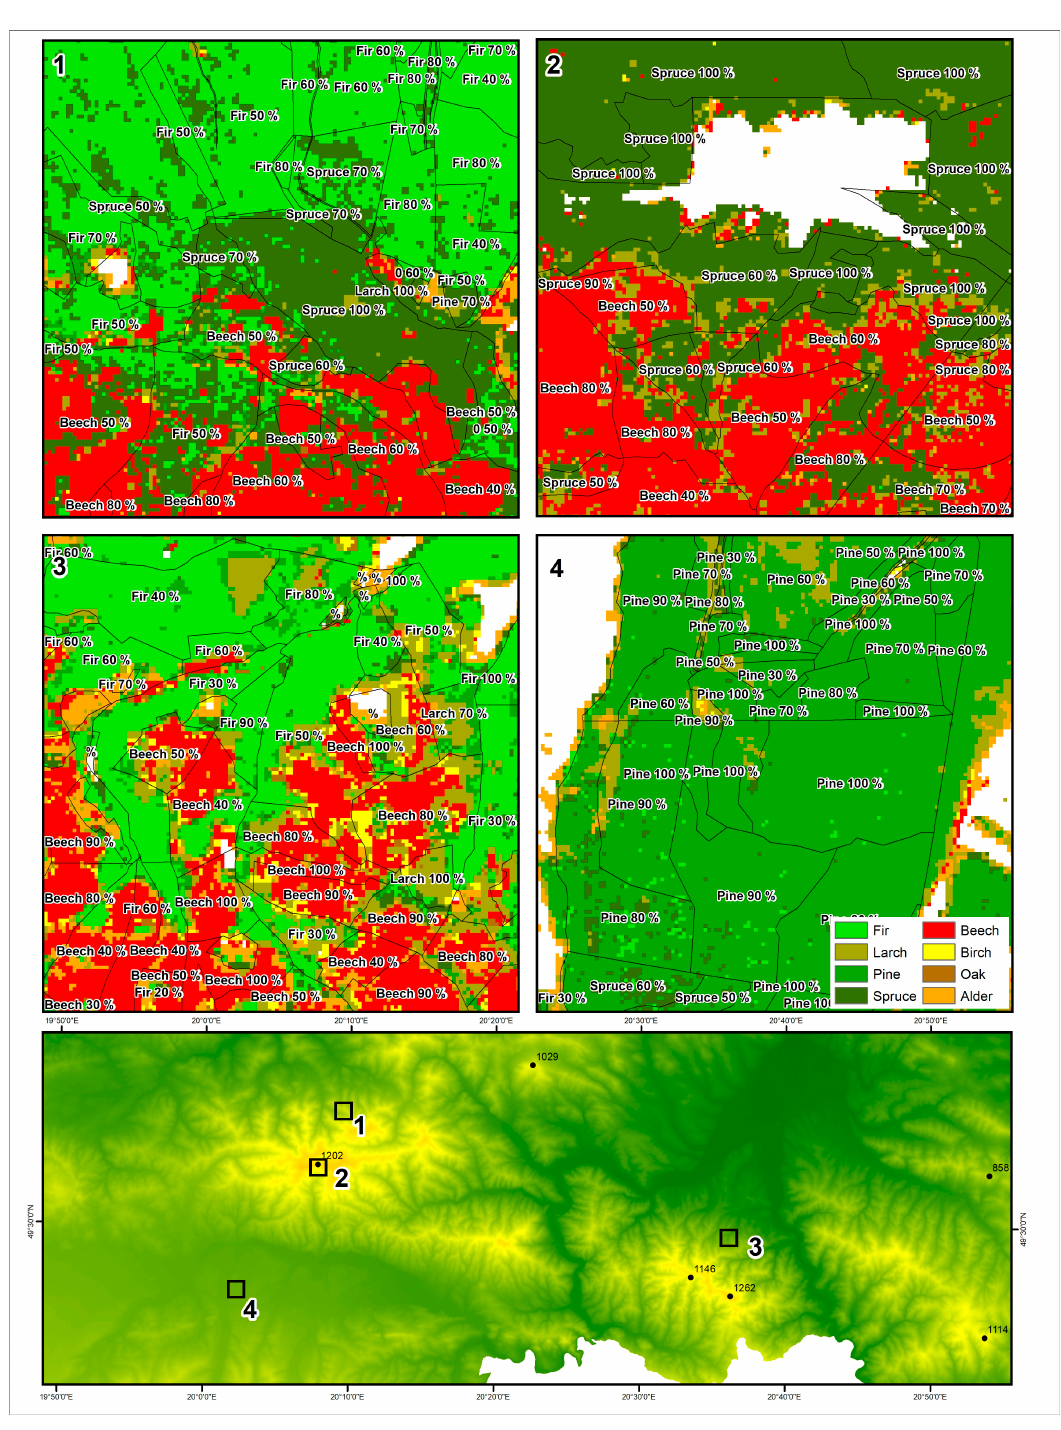
Figure 7. Fragment of the tree species map derived using the stratification approach based on the multi-temporal Sentinel-2 data combined with topographic features with overlaid forest stands with information on the dominant tree species and percentage of it within the stand. The bottom map shows the exact extend and location of the subsets presented above overlaid on the SRTM DEM.